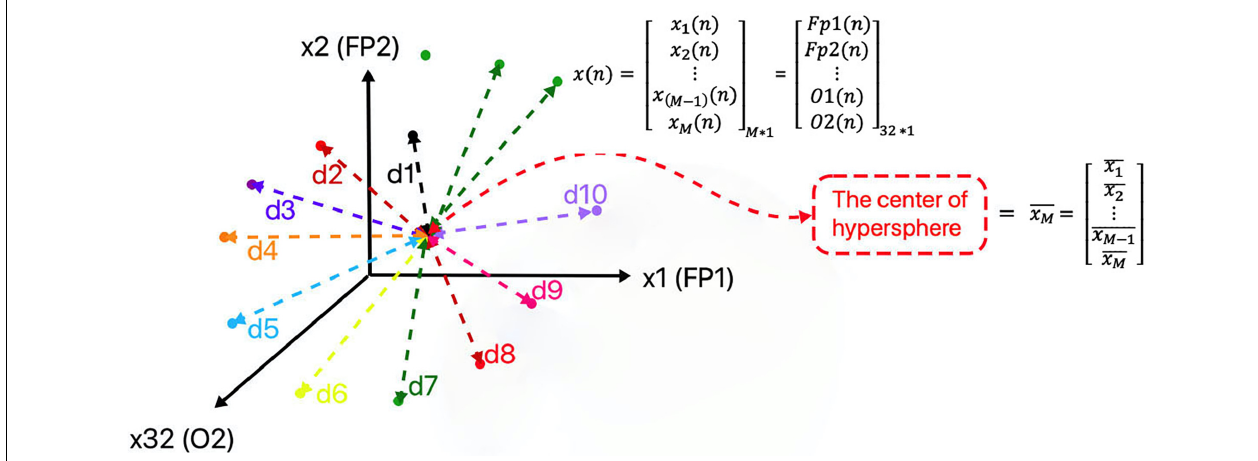
FIGURE 3 | Representation of points and the distances of points from the center of the hypersphere, in the constructed phase space of the signal (due to the limitation of representation of space dimensions number, only three dimensions of phase space are displayed).